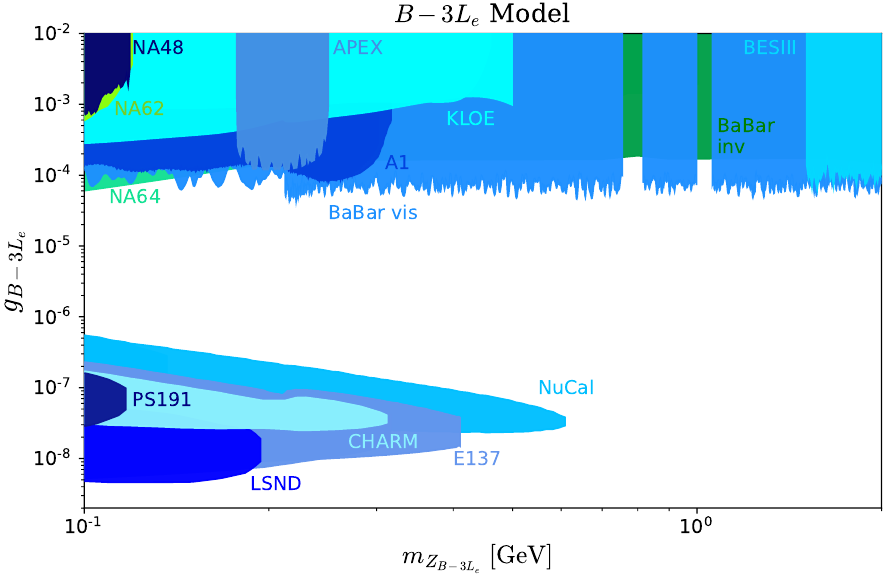
Figure 10 . Similar to figure 9 but for the B − 3 L e model. Here there is no contribution from the LHCb experiment or from KLOE due to the absence of muon